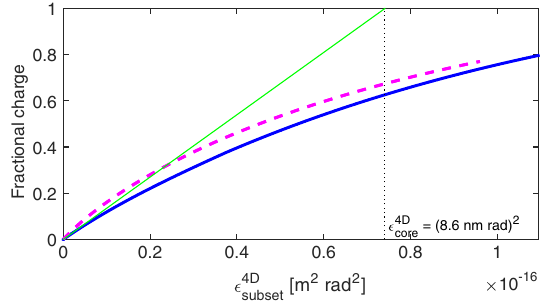
FIG. 12. Reconstruction of the cumulative charge distribution with respect to the fractional emittance (blue solid line) from the measurement of Pegasus electron beam with a TEM300. The solid green line shows the tangent line to the reconstructed curve at the core to linearly extrapolate the core emittance. The dashed pink line is the analytical curve of a 4D Gaussian